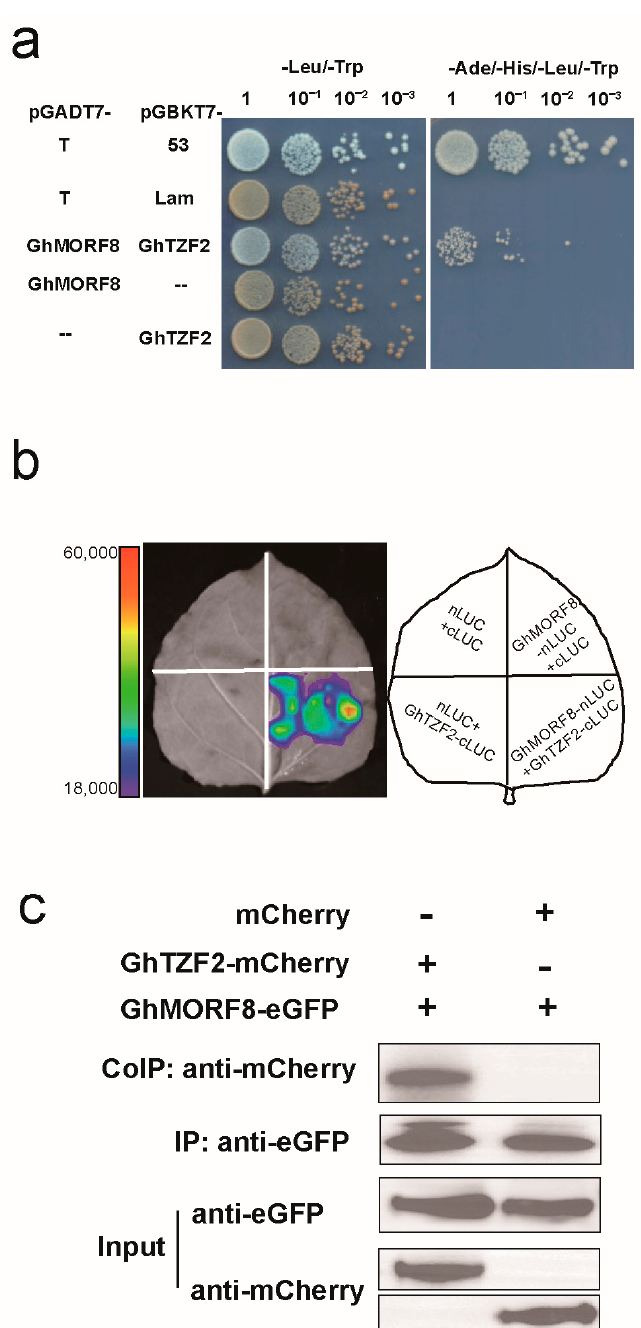
Figure 5. GhTZF2 directly interacted with GhMORF8. ( a ) Y2H assay of interaction between GhTZF2 and GhMORF8. pGBKT7 and aGADT7 empty vectors were used as controls. ( b ) LCI assay of interaction between GhTZF2 and GhMORF8. GhTZF2 and GhMORF8 were fused to the carboxyl- terminal and amino-terminal of firefly luciferase (cLUC and nLUC), respectively. The GhTZF2-cLUC and GhMORF8-nLUC constructs were transiently co-expressed in the leaves of N. benthamiana , using nLUC and cLUC as the controls. Fluorescence signal intensities represent their binding activities. The left bars indicate heat map scales. ( c ) Co-IP of transiently co-expressed GhTZF2-mCherry and GhMORF8-eGFP in N. benthamiana leaves. Soluble protein extracts before (Input) and after (IP and Co-IP) immunoprecipitation with anti-GFP affinity agarose beads were detected by immunoblot with anti-GFP and anti-mCherry antibodies, respectively.